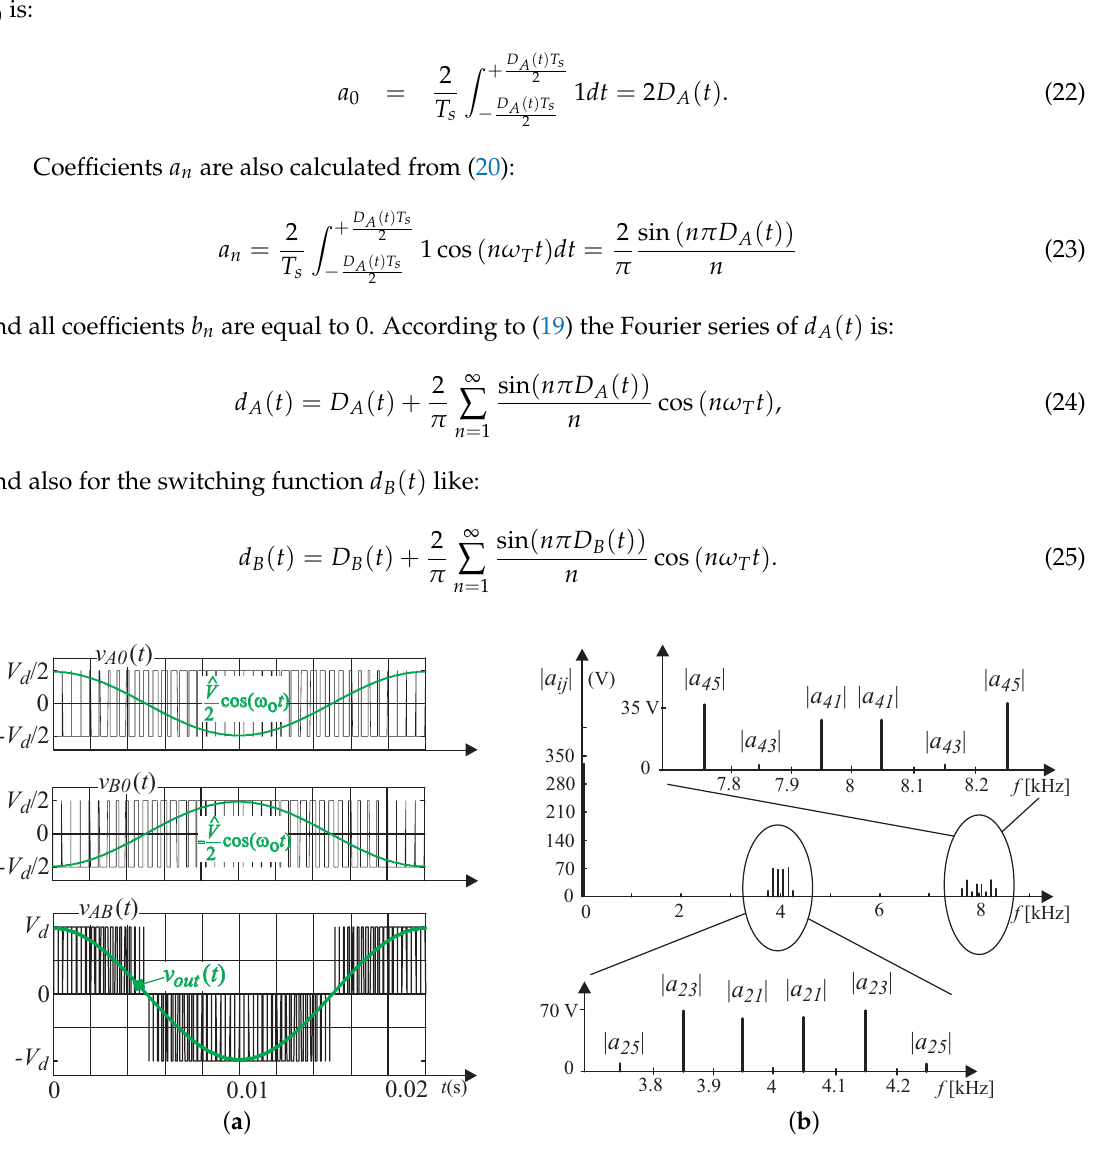
Figure 2. ( a ) Output voltages: v A 0 ( t ) , v B 0 ( t ) and v AB ( t ) with appropriate modulation functions and ( b ) Spectral lines for three-level output